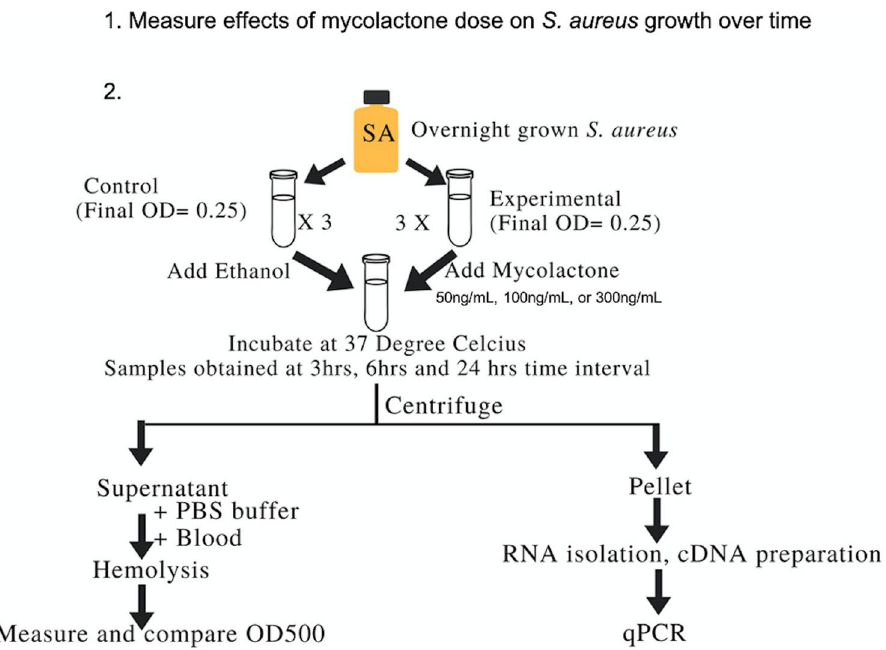
Figure 6. Overall approach to determine the effect of mycolactone on S. aureus growth, hemolytic activity and virulence gene